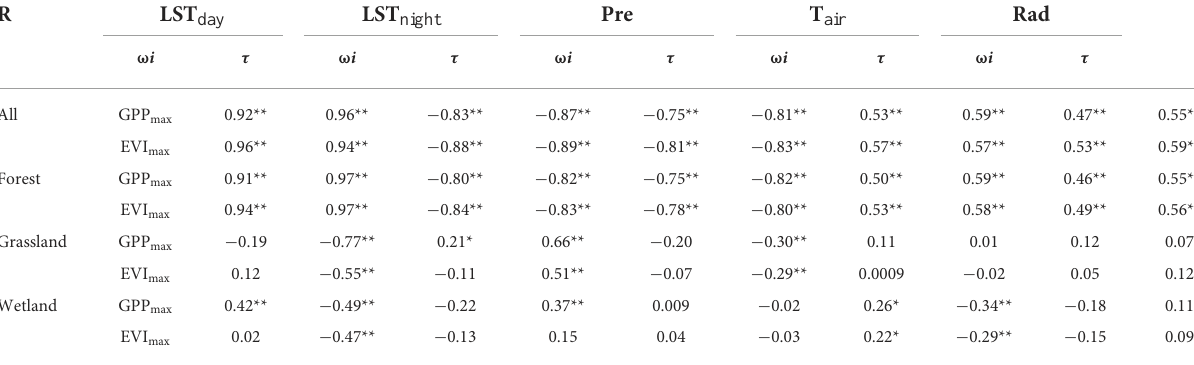
TABLE 1 Correlation analysis between the indirect impacts and growth offset of urbanization on GPP max and EVI max and five responsible variables (LST day , LST night , Pre, Rad, T air , and